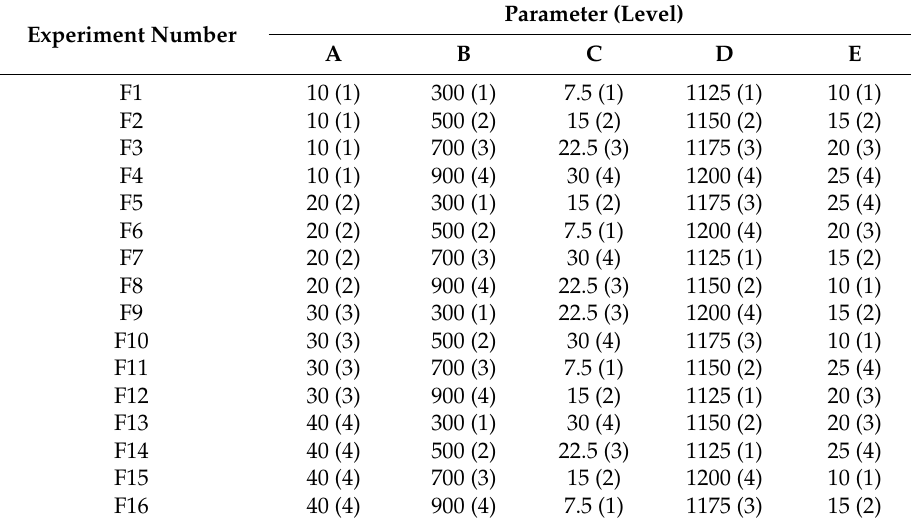
Table 2. Orthogonal array for L 16 (4 5 ).